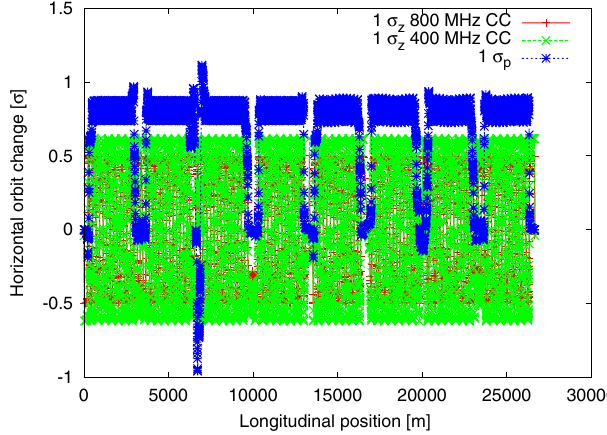
FIG. 9. (Color) Comparison of horizontal orbit change of a particle with 1 (cid:3) z offset for 800-MHz global crab-cavity case (red); of a particle with 1 (cid:3) z offset for 400-MHz global crab- cavity case (green); and for a 1 (cid:3) p off-momentum particle (blue), in the nominal LHC collision optics. The orbit change due to the crab cavity is comparable to, or smaller than, the dispersive orbit